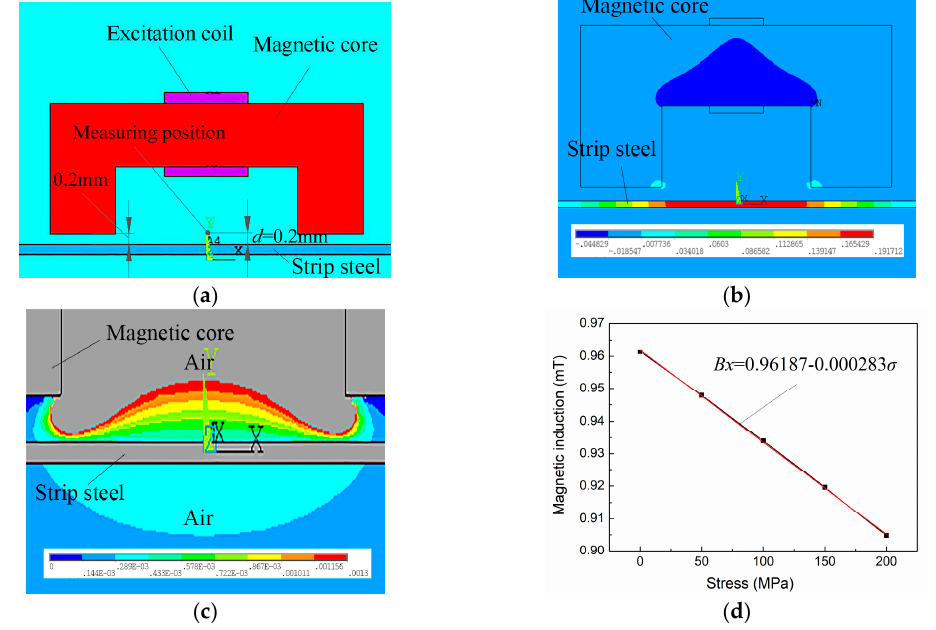
Figure 6. Numerical simulation analysis of exciting parameters: ( a ) Finite element model; ( b ) distribution of magnetic induction within detected strip steel; ( c ) magnetic induction surrounding detected strip steel; and ( d ) change in magnetic induction for detected point with stress. The material used as the detection candidate was Q235 (E235B in ISO630). The thickness was 1.0 mm. The mechanical and magnetic characteristic parameters are provided in Table 2.